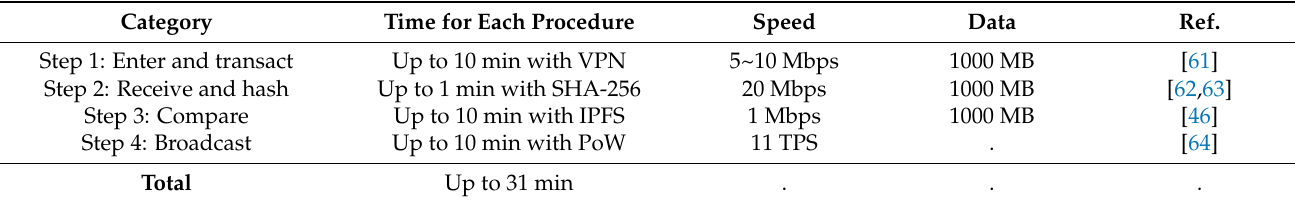
Table 5. Processing speed and available data size for each NSCC